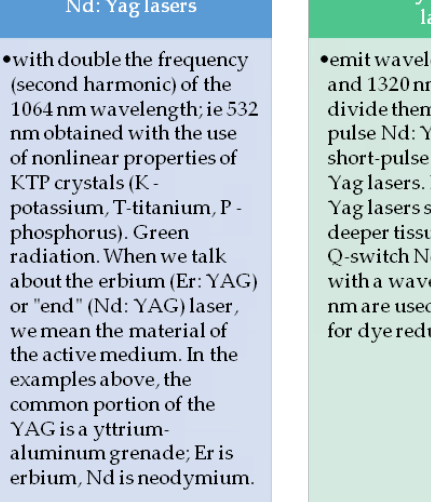
Figure 1. Brief characteristics of the most commonly used lasers.